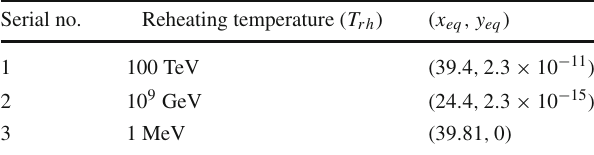
Table1 Summaryoftheinitialconditionsatthematter-radiationequal- ity at different reheating temperatures is shown Serial no.